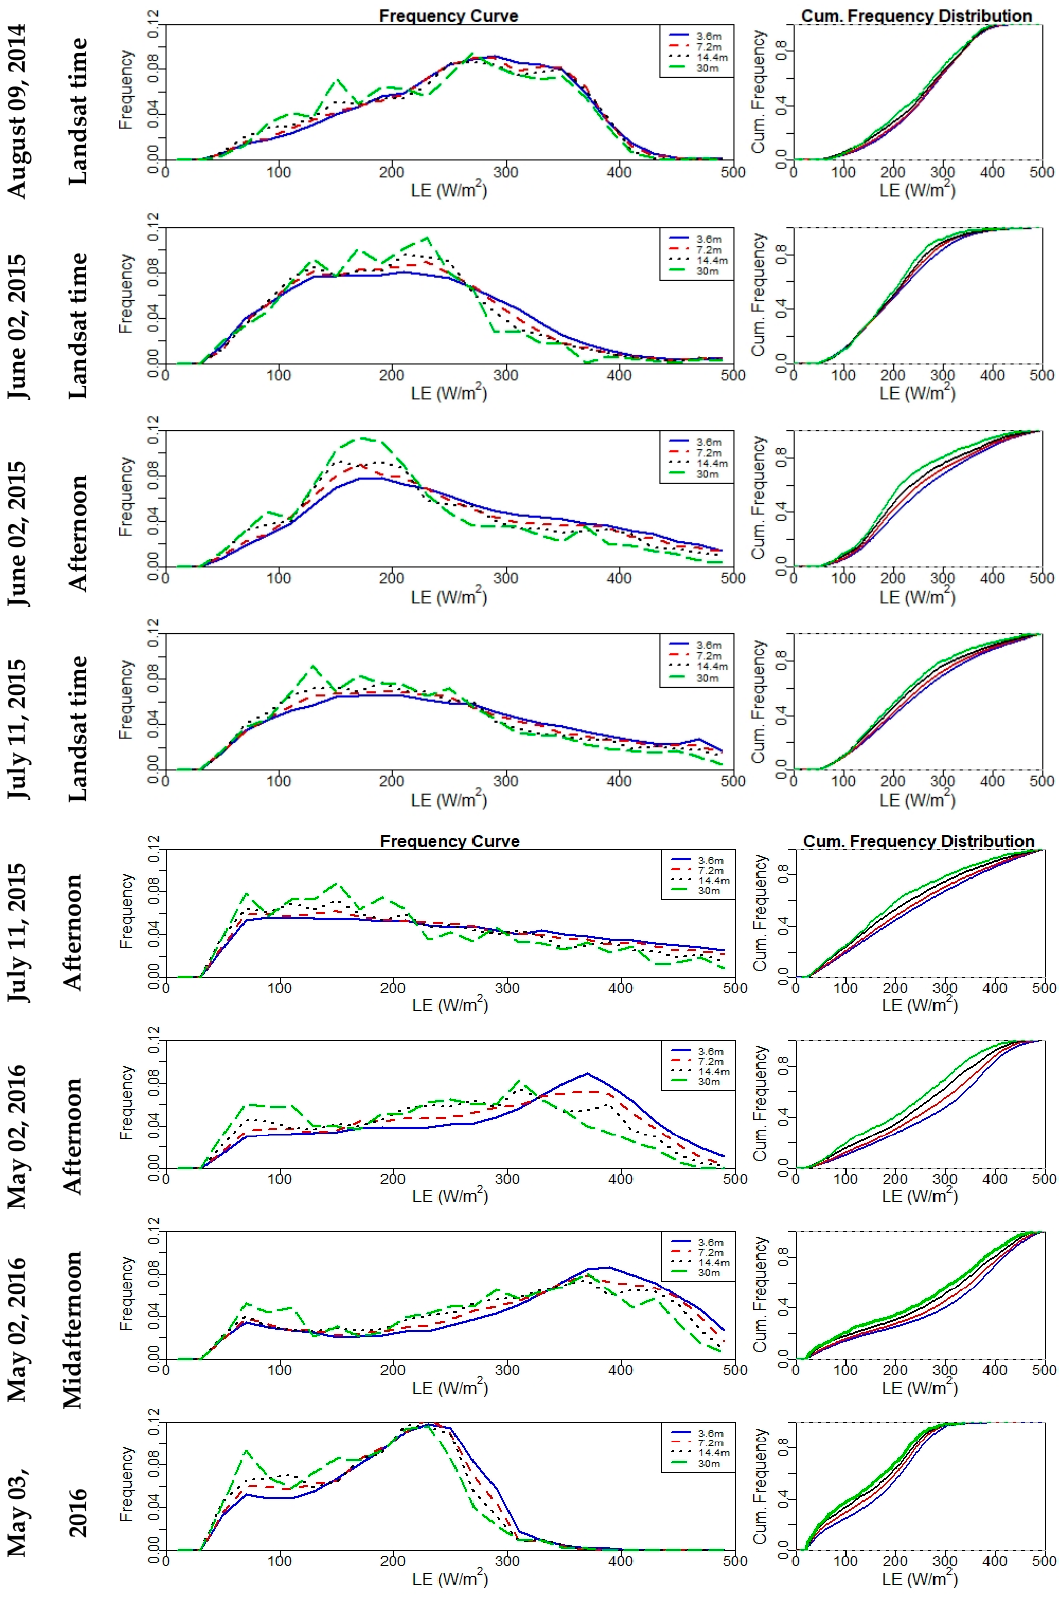
Figure 14. Frequency curve ( left ) and cumulative frequency distribution ( right ) plots of instantaneous LE for all sUAS flights at 3.6 m, 7.2 m, 14.4 m, and 30 m.